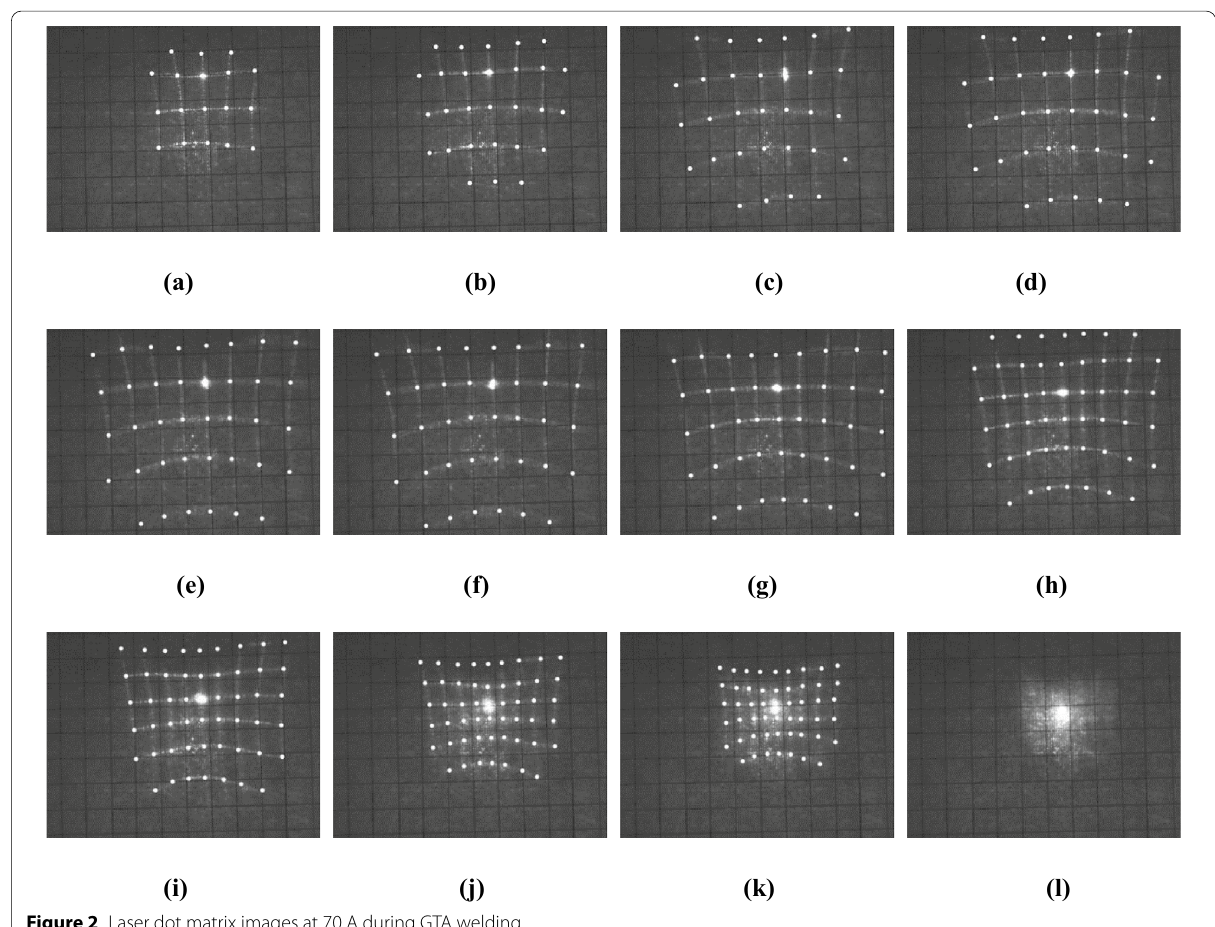
Figure 2 Laser dot matrix images at 70 A during GTA welding